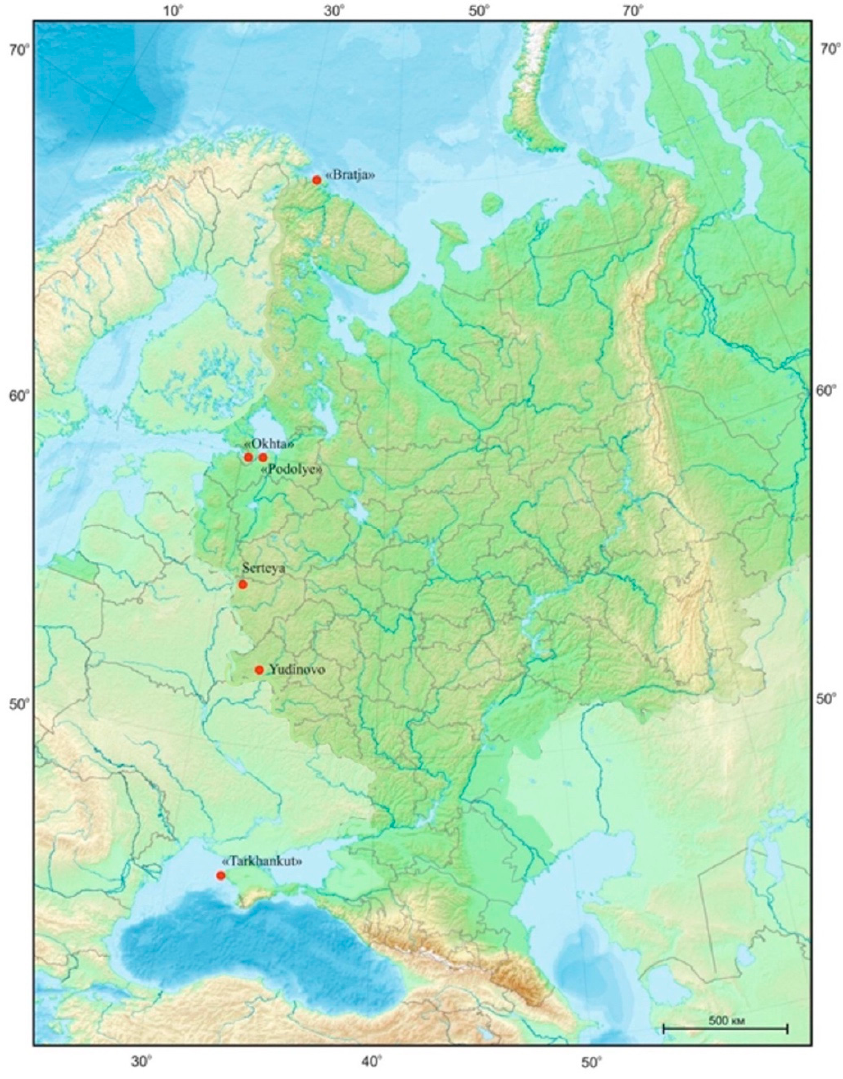
Figure 1. Map of studied archaeological sites of Eastern Europe.